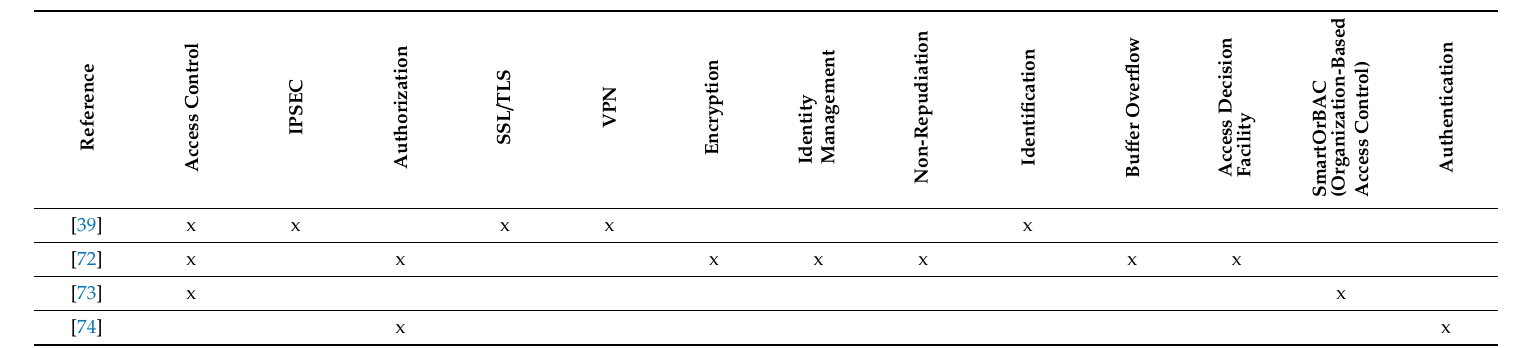
Table A4. The list of SIFs impacting security